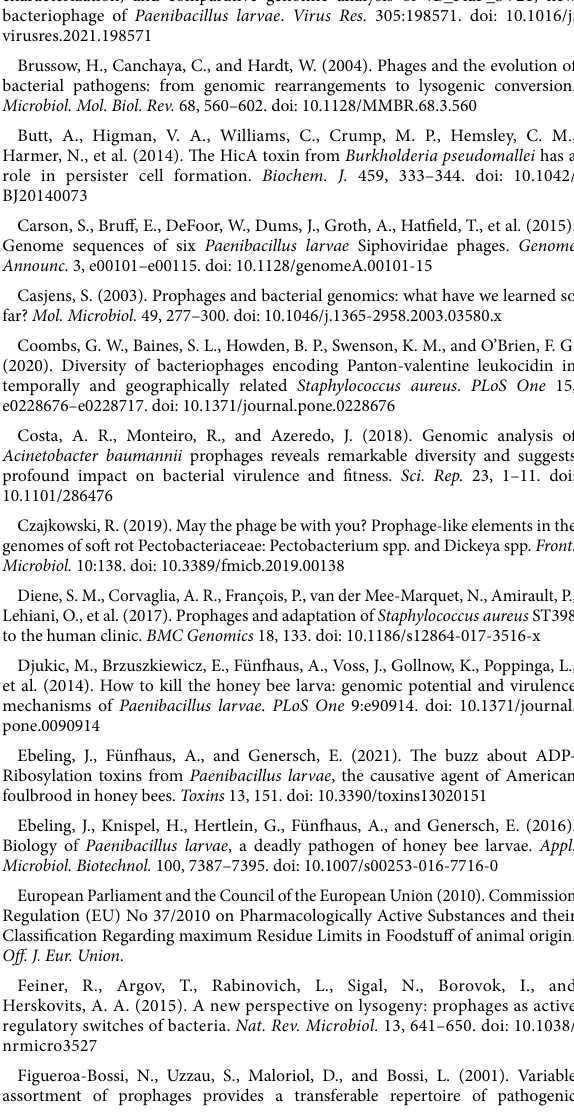
Figueroa-Bossi, N., Uzzau, S., Maloriol, D., and Bossi, L. (2001). Variable assortment of prophages provides a transferable repertoire of